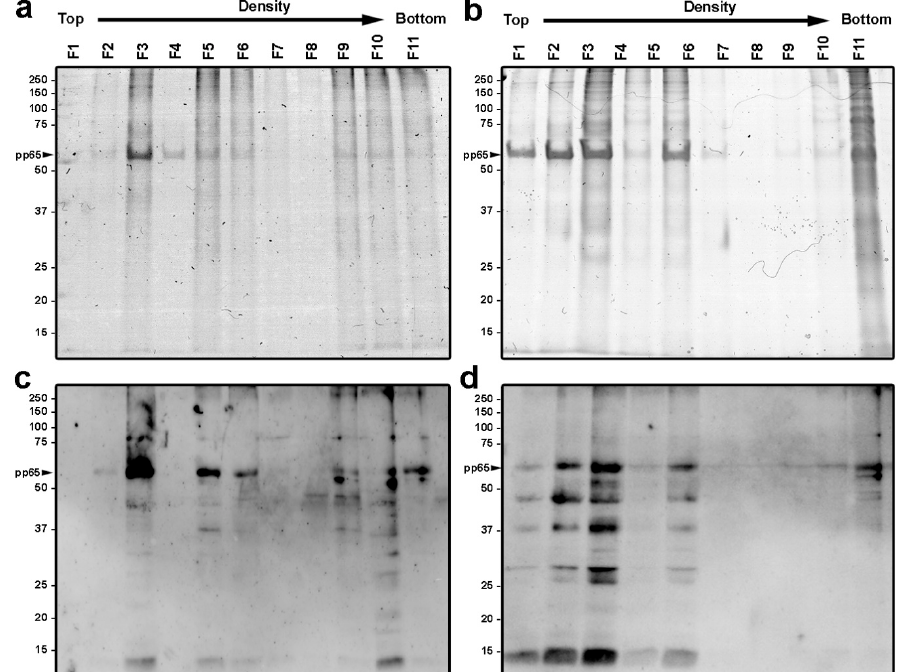
Figure 5. Protein composition of gradient fractions derived from MRC-5 and ARPE-19 infected cells. ( a , b ) Coomassie-staining SDS-PAGE analysis determining the protein distribution of each of the 11 fractions purified by centrifugation from supernatants of infected MRC-5 ( a ) and ARPE-19 ( b ) cells. Images were directly scanned using a Scanner Epson Perfection V500 photo. ( c , d ) Western blot analysis of the fractions using a polyclonal anti-CMV antibody. Lanes are indicated from 1 to 11, fraction 1 corresponding to the top (lower density) of the gradient tube and fraction 11 to the bottom (higher density). Analysis of the image was performed using a Chemidoc TM MP Imaging System (Biorad, Hercules, CA, USA). Settings MRC-5: Exposure time (s) 122.124 (optimal autoexposure); Settings ARPE-19: Exposure time (s) 1.051 (rapid autoexposure). The expected migration of tegument pp65 protein is indicated with a black arrowhead.